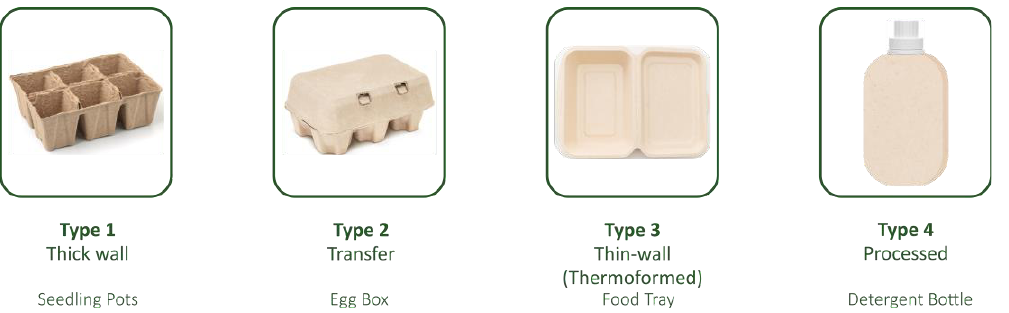
Figure 2. Four different types of fibre moulded products.